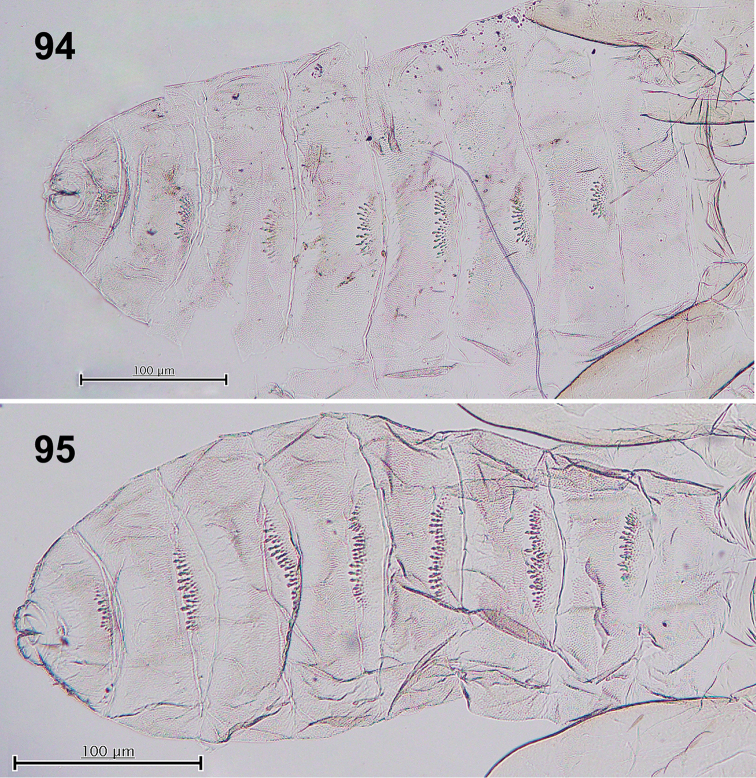
Dorsal view of pupal abdominal segments. 94Schizomyiasoyogo95Schizomyiasasaki. Scale bar: 100 µm.